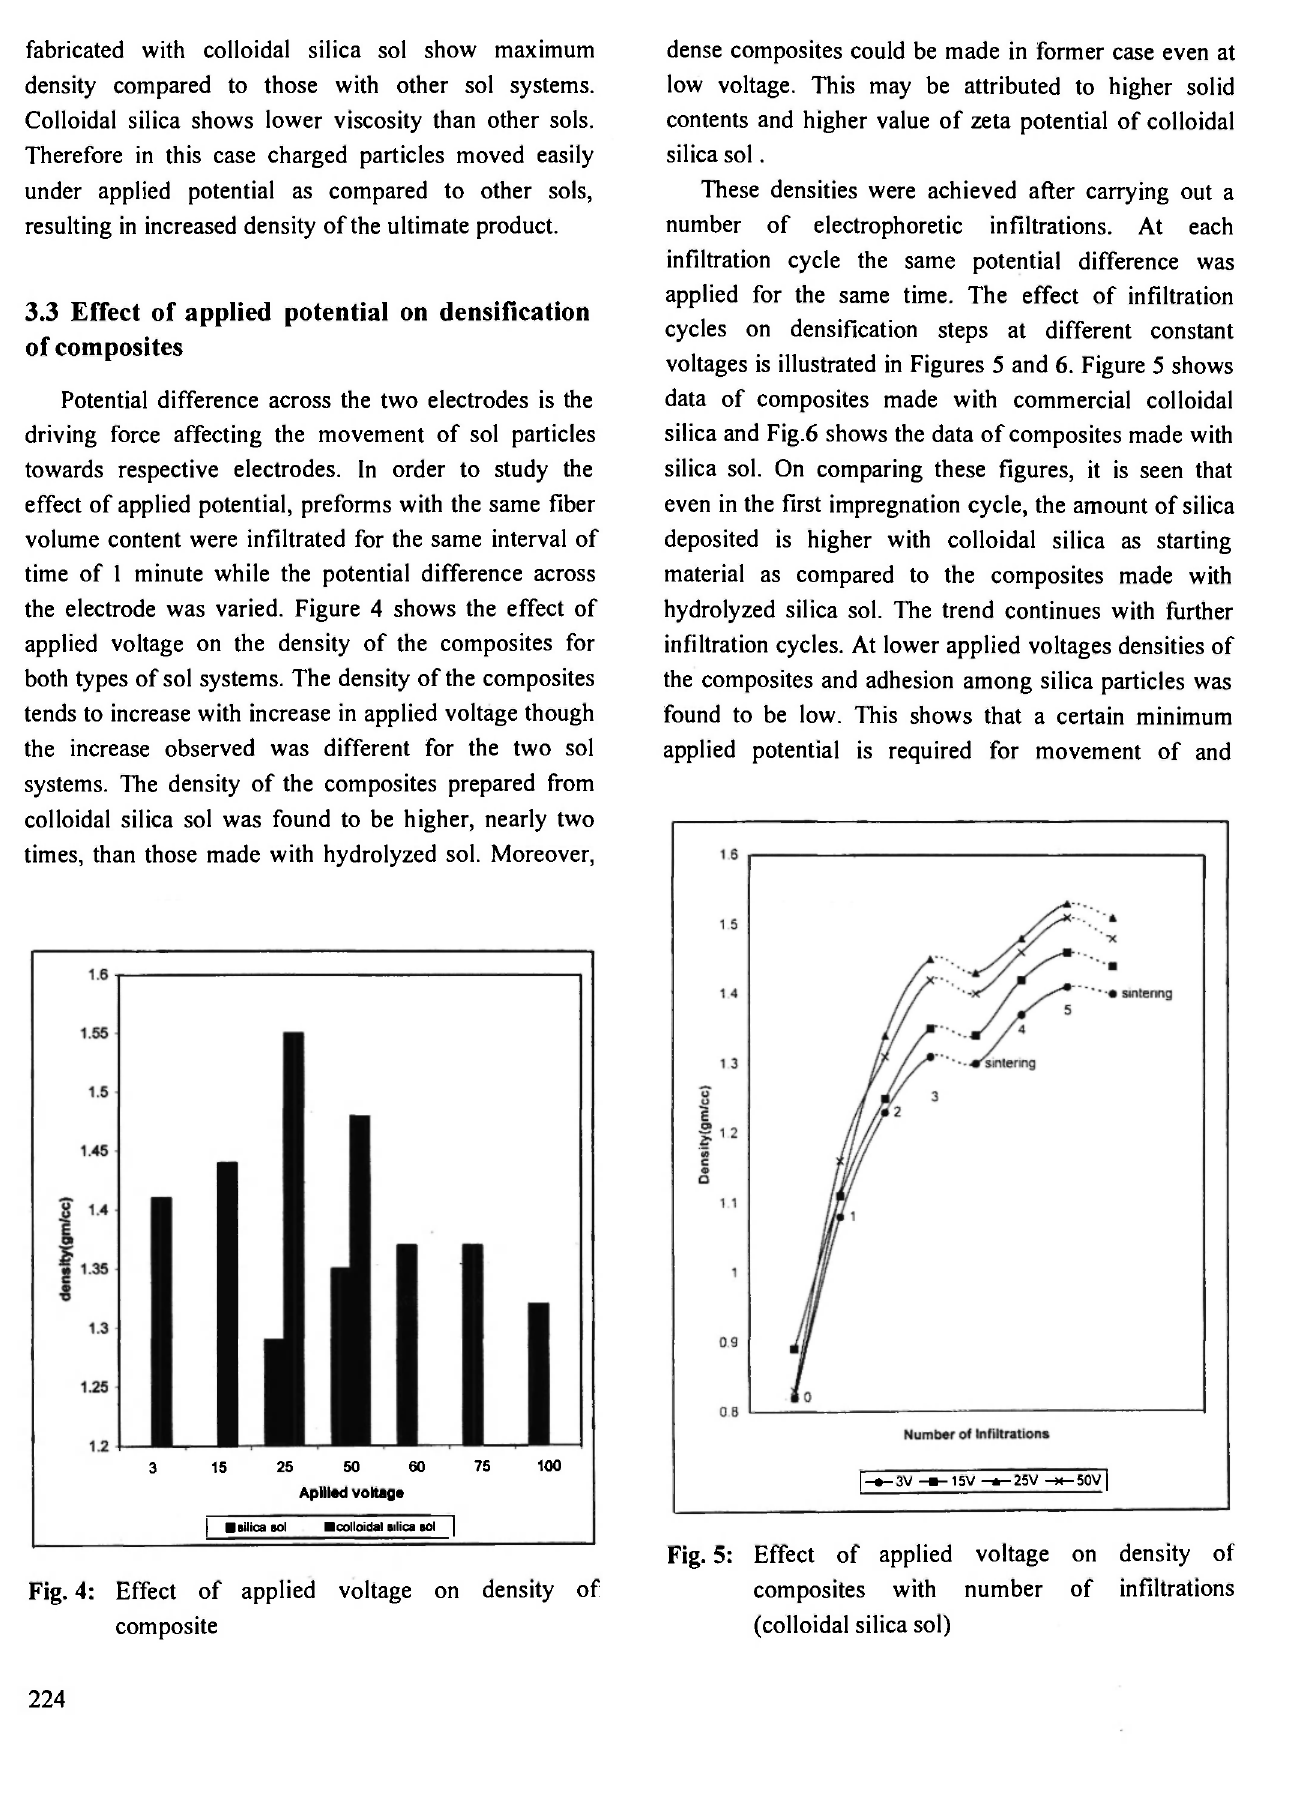
Fig. 4: Effect of applied voltage on density of composite